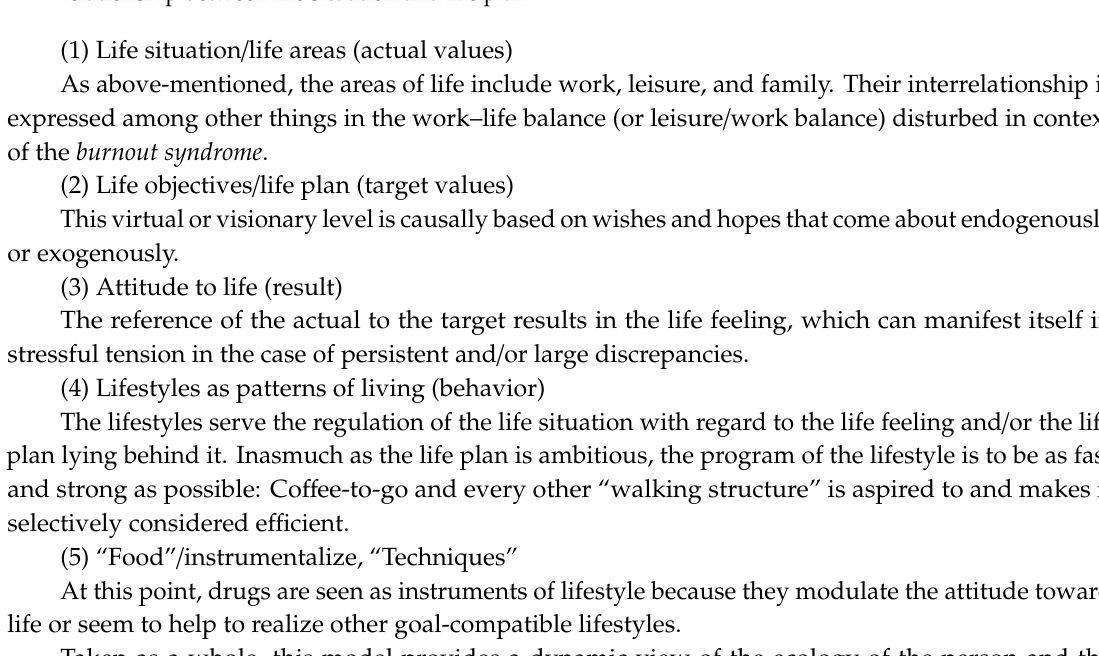
Figure 5. Closed-loop model of the lifestyle as the resultant of the attitude to life, which is based on the relationship between life situation and life plan.